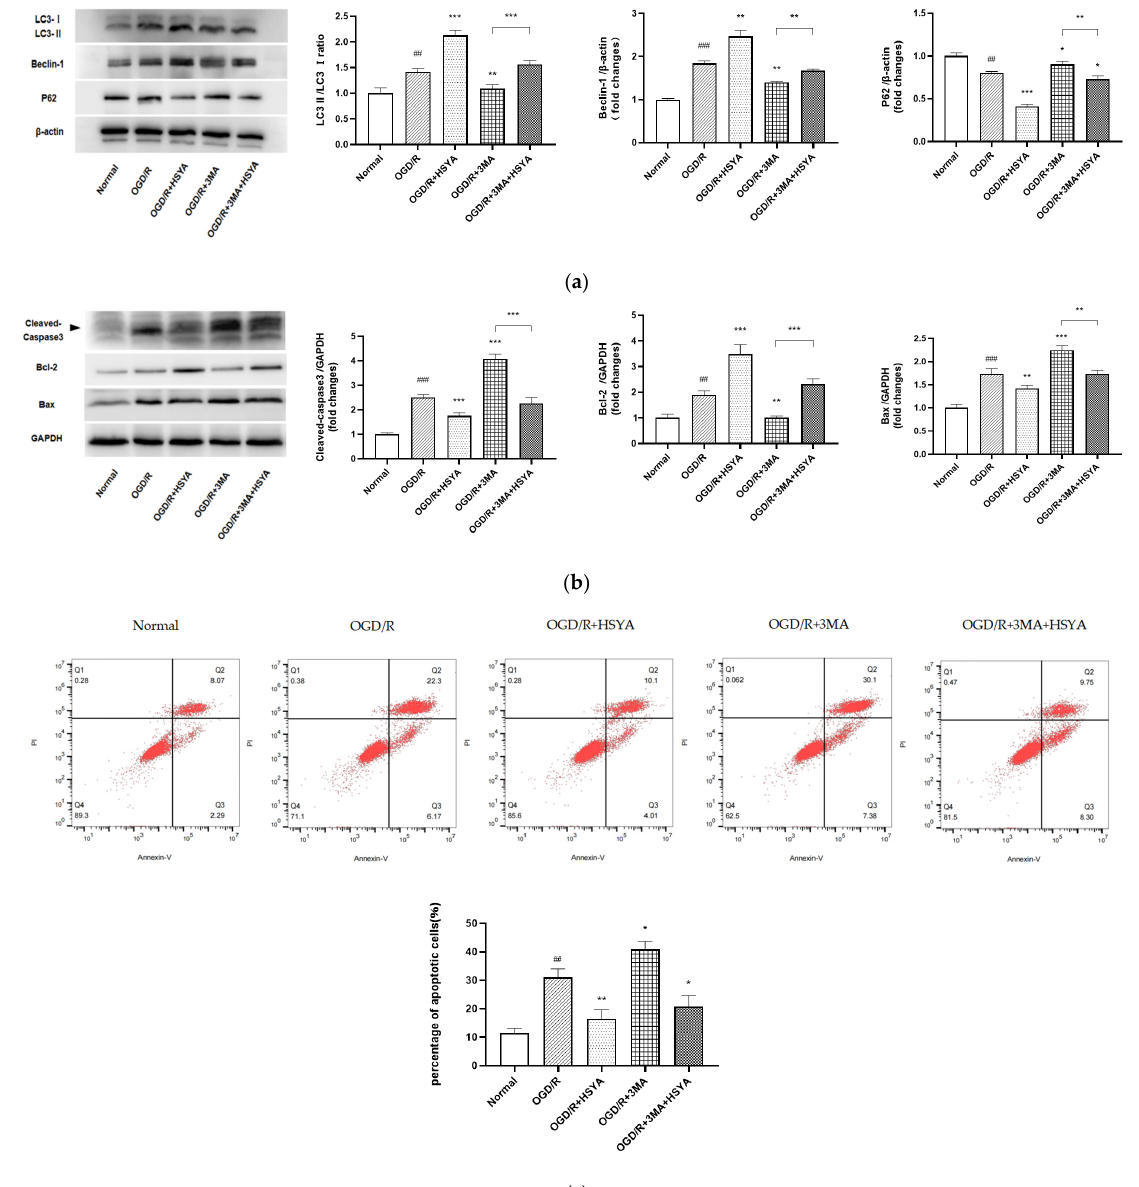
Figure 6. Enhanced autophagic activity mediates the protective role of HSYA in OGD/R cytotoxicity. ( a ) Western blotting was performed to detect the expression of LC3, Beclin-1, and P62. β -actin was used as an internal control. ( b ) Western blotting was performed to detect the expression of Bcl-2, BAX, and Cleaved-Caspase-3. GAPDH was used as an internal control. ( c ) Flow cytometry detection of Annexin V-FITC/PI double-stained cells in different treatment groups. Staining shows that HSYA reduces the percentage of OGD/R-induced apoptotic SH-SY5Y cells. The upper and lower right quadrants of the flow cytometry plot depict late apoptosis and early apoptosis, respectively. Usually, the total percentage of early and late apoptotic cells is used to indicate the total apoptotic cells. Results are representative of three independent experiments, and the data were statistically analyzed using one-way ANOVA and expressed as mean ± standard deviation. (Note: compared with the normal group, ### p < 0.001, ## p < 0.01; compared with the OGD/R group, *** p < 0.001, ** p < 0.01, * p <